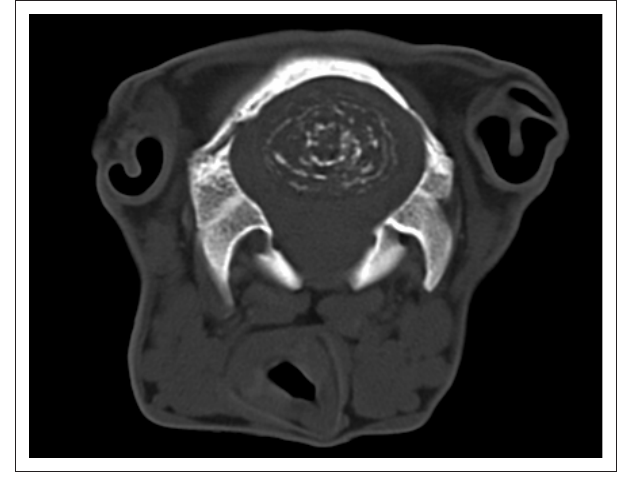
FIGURE 1: One of the CT images showing the onion-ring appearance.